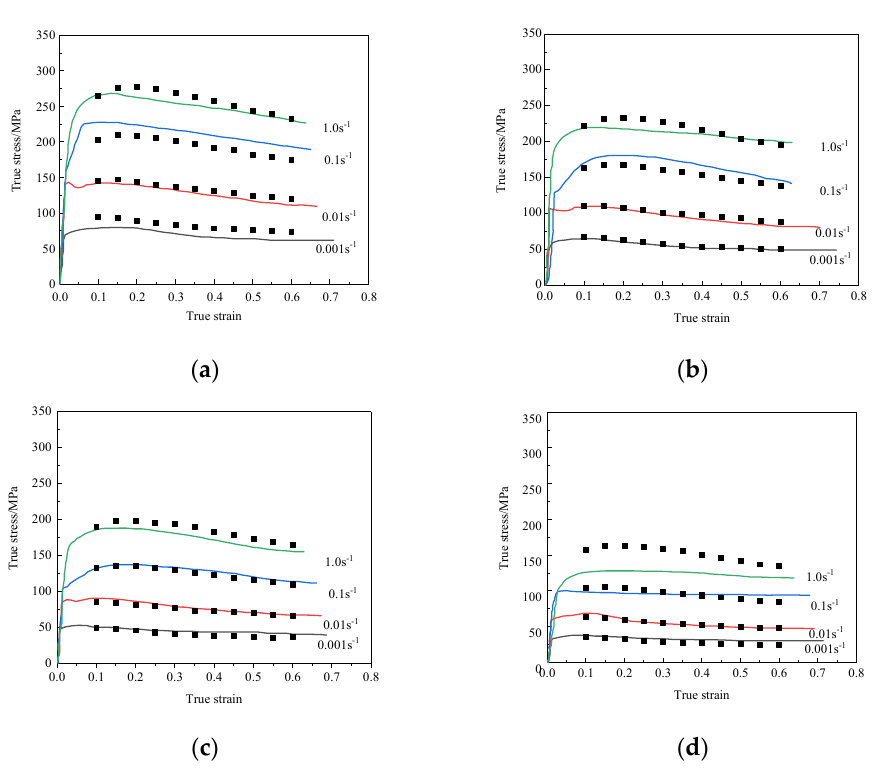
Figure 11. Experimental and calculated data ( a ) T = 990 °C ( b ) T = 1040 °C ( c ) T = 1090 °C ( d ) T = 1140 °C.